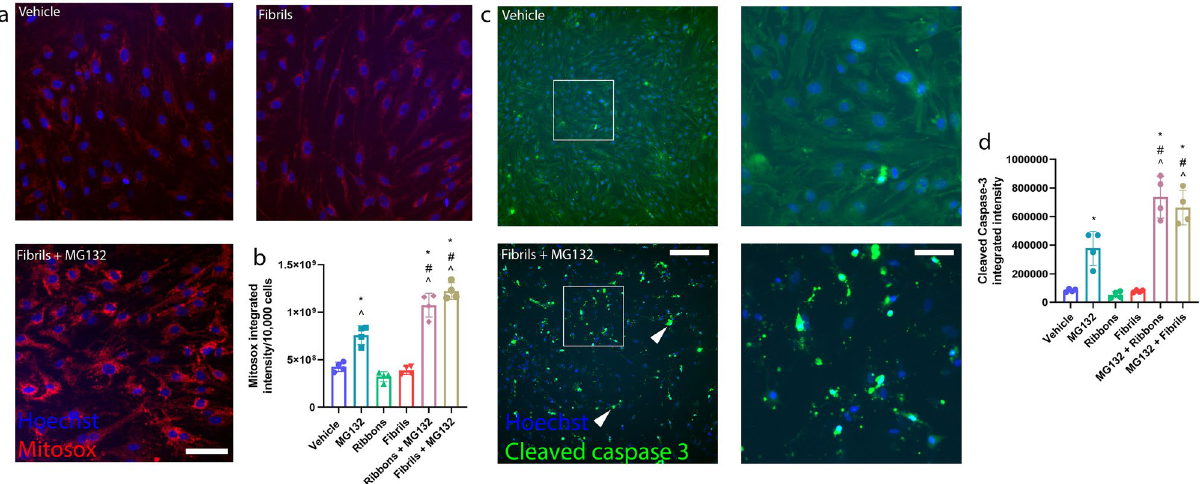
Figure 9. Cell death of primary human brain pericytes in response to pre-treatment with MG132 and α-syn. ( a ) Representative immunocytochemistry images of MitoSOX staining in primary human brain pericytes after treatment with vehicle, α-syn fibrils (100 nM), MG132 (5 µM) pre-treatment for 6 h following α-syn fibrils (100 nM) incubation and ( b ) graph showing the integrated intensity of MitoSOX after MG132 (5 µM) pre-treatment for 6 h following α-syn fibrils (100 nM) incubation. Scale bar = 50 µm. ( n = 4 epilepsy cases, mean ± SD). * p < 0.05 compared to vehicle, ^ p < 0.05 compared to ribbons or fibrils, # p < 0.05 compared to MG132; one way ANOVA with Tukey’s multiple comparisons test. ( c ) Representative immunocytochemistry images of cleaved-caspase 3 staining in primary human brain pericytes pre-treated with 5 µM MG132 for 6 h prior to incubation vehicle or MG132 and fibrils. Scale bar = 100 µm. ( d ) Graph showing cleaved-caspase 3 integrated intensity after pericytes were pre-treated with 5 µM MG132 prior to co-incubation with either ribbons (100 nM) or fibrils (100 nM). ( n = 4 epilepsy cases, mean ± SD). * p < 0.05 compared to vehicle, # p < 0.05 compared to MG132 treatment, ^ p < 0.05 compared to either ribbon or fibrils; one way ANOVA with Tukey’s multiple comparisons